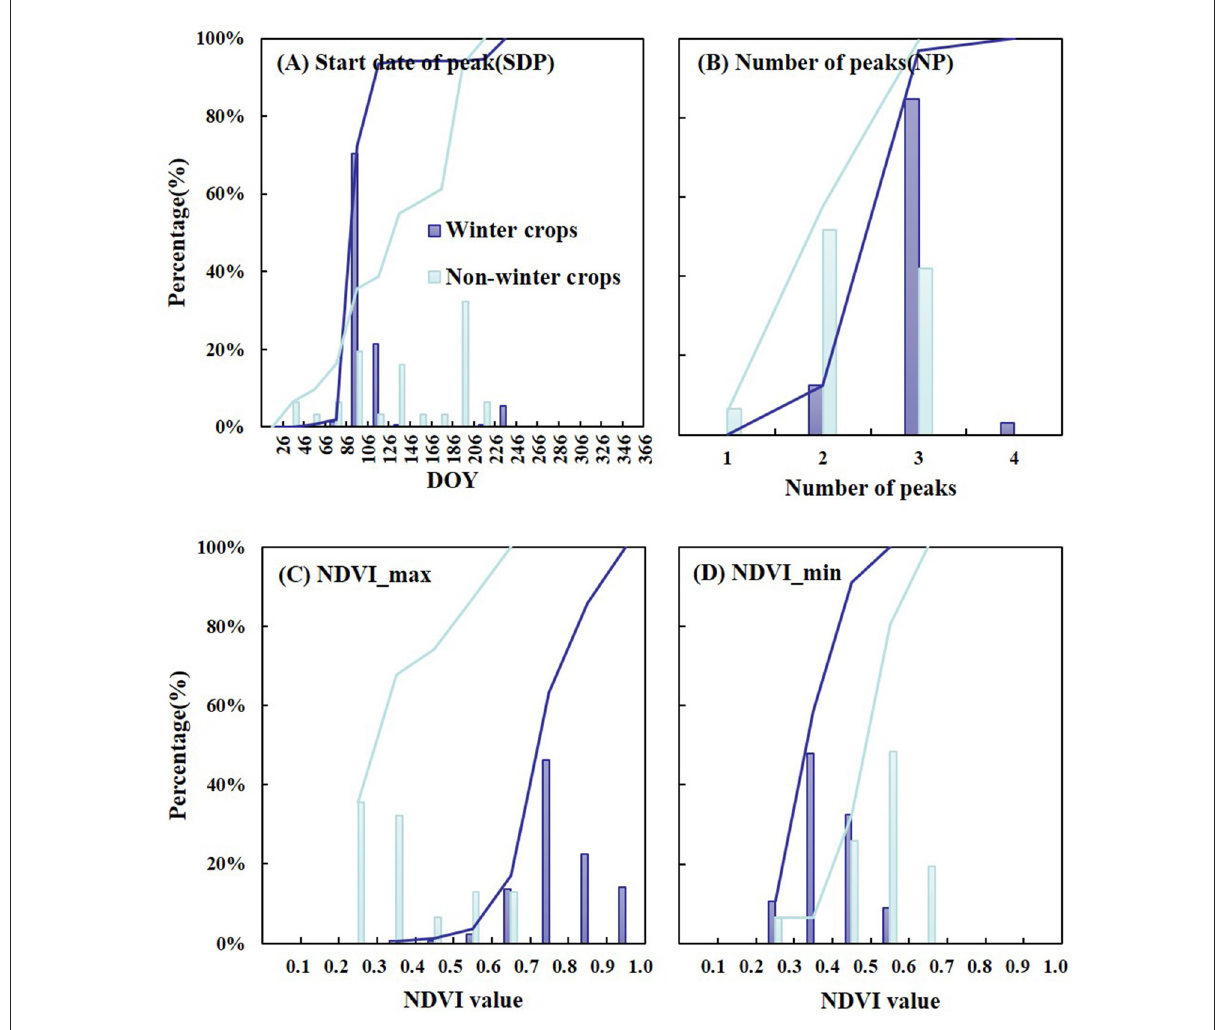
FIGURE7 Signature analysis of winter crops and non-winter crops at (A) SDP, (B) NP, (C) NDVI_max, and (D) NDVI_min using the histogram statistics